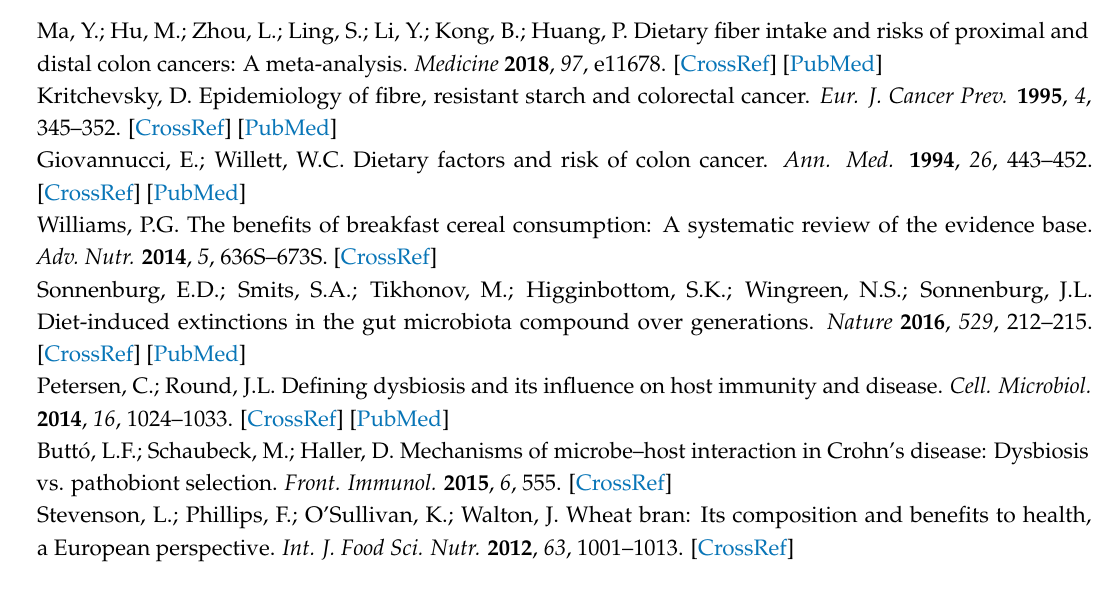
s1. Supplementary Table S1: Effects of wheat bran and BARLEYmax intake on body weight and body mass index, body fat, and blood pressure at baseline and after 4 weeks. Supplementary Table S2: Effects of wheat bran and BARLEYmax on serum biochemistry at baseline and after 4 weeks. Supplementary Table S3: Effects of wheat bran and BARLEYmax on blood markers. Supplementary Table S4: Changes in relative abundances of bacteria phyla in fecal samples between baseline and week 4. Supplementary Table S5: Changes in relative abundances of selected bacteria genera in fecal samples between baseline and week 4. Supplementary Table S6: Changes in fecal SCFA and organic acid concentrations of subjects between baseline and week 4. Supplementary Table S7: Changes in concentrations of fecal putrefaction products in stool samples between baseline and week